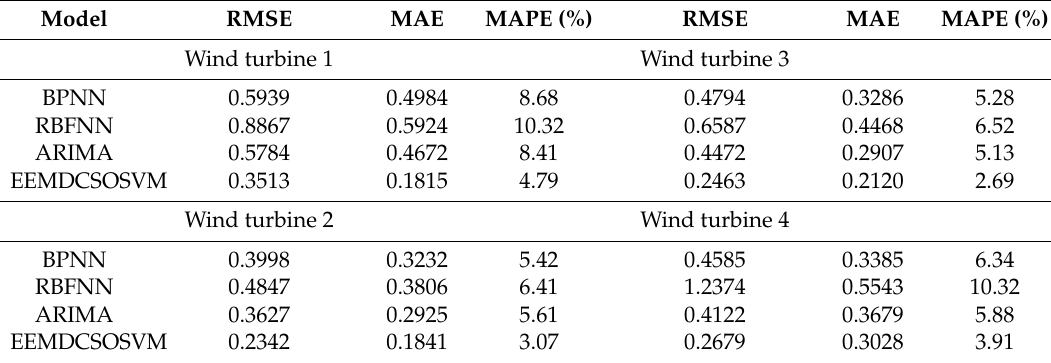
Table 4. Comparison of the value of RMSE, MAE, and MAPE between the proposed model and some traditional models (BP RBF